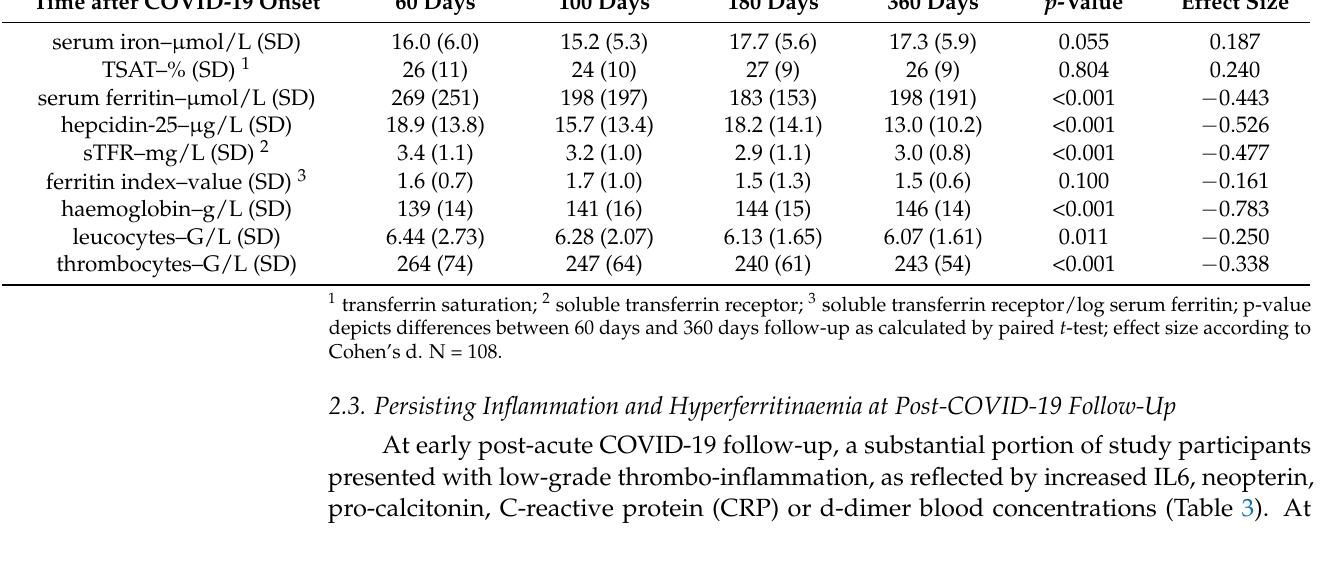
Figure 1. Frequency and phenotype of iron deficiency and anaemia during COVID-19 convalescence. ( a ) Prevalence and phenotype of iron deficiency 60, 100, 180 and 360 days after COVID-19 onset. ( b ) Prevalence and phenotype of anaemia 60, 100, 180 and 360 days after COVID-19 onset. N (%) indicates the total N of anaemic patients and the relative portion of the total cohort for each time point. Table 2. Iron studies and haemogram during COVID-19 convalescence.